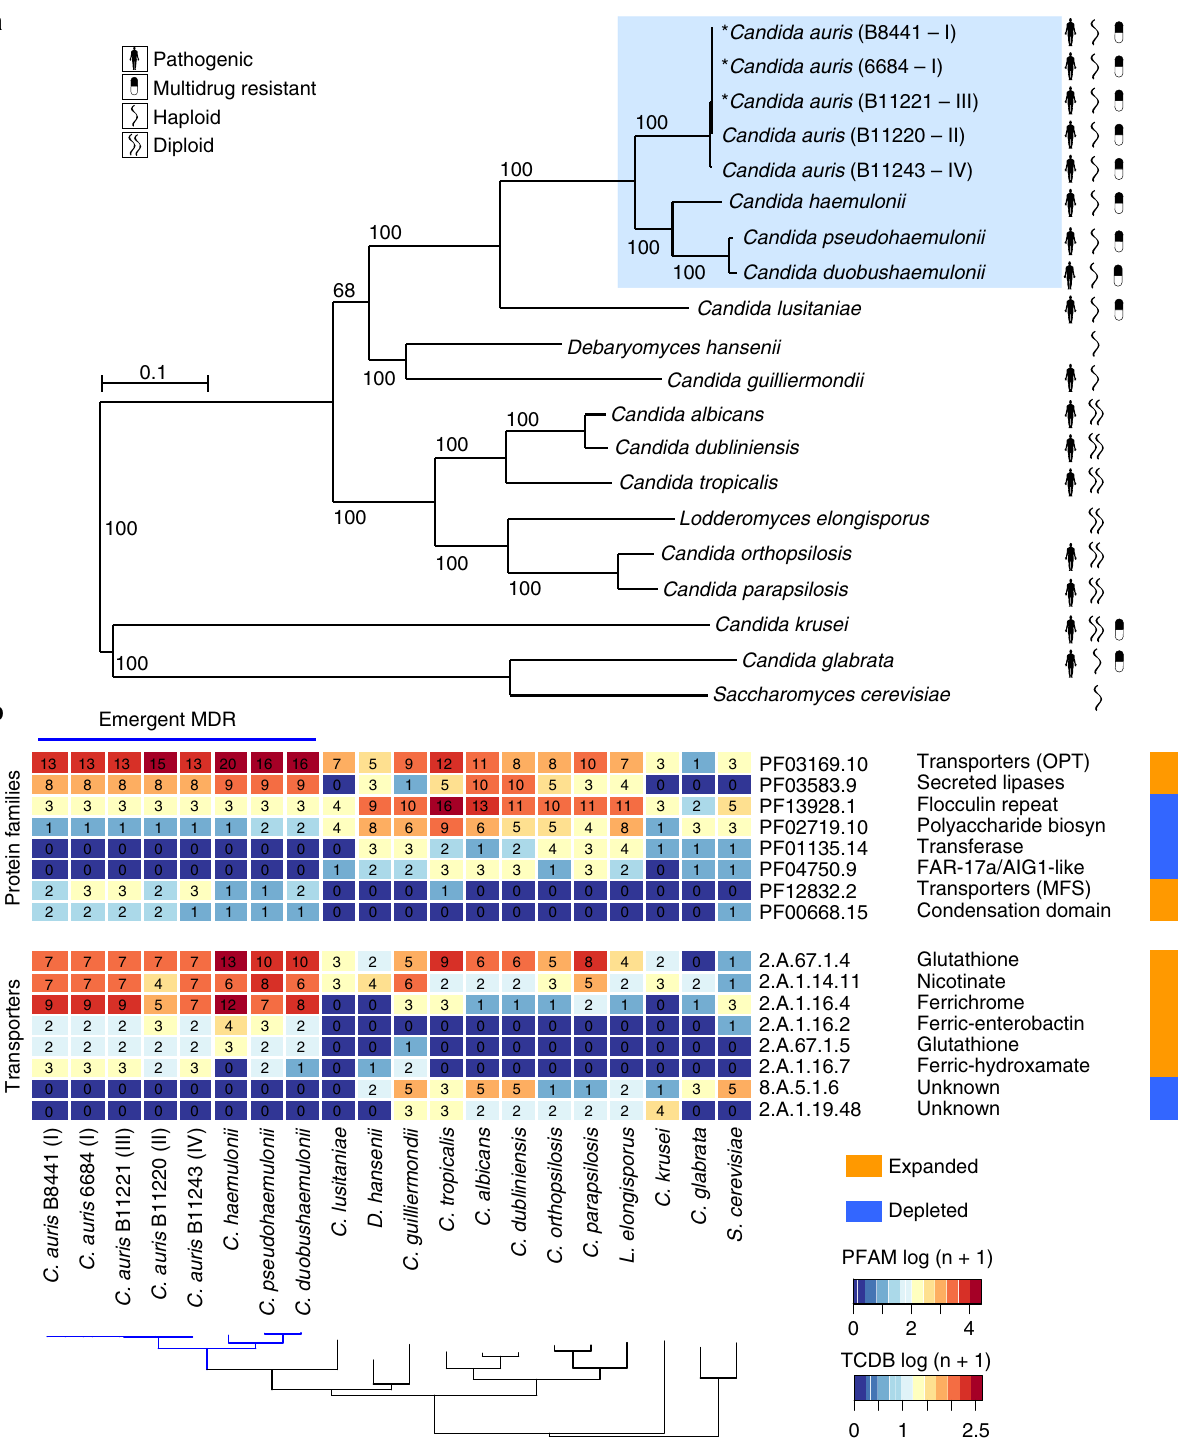
Fig. 3 Phylogenomic and gene family changes in Candida auris and related species. a Maximum likelihood phylogeny using 1570 core genes based on 1000 replicates, among 20 annotated genome assemblies, including Candida auris, C. haemulonii (B11899), C. duobushaemulonii (B09383), and C. pseudohaemulonii (B12108), and closely related species. Branch lengths indicate the mean number of changes per site. b Heatmap depicting results of protein family enrichment analysis (PFAM domains; corrected p -value < 0.05) comparing the gene content of C. auris strains representing each clade, C. haemulonii , C. duobushaemulonii , and C. pseudohaemulonii , and other closely related species, including C. lusitaniae , C. albicans , C. krusei , and C. glabrata . Values are colored along a blue (low counts) to red (high counts) color scale, with color scaling relative to the low and high values of each row. Each protein family domain has a color code (right) indicating whether expanded or